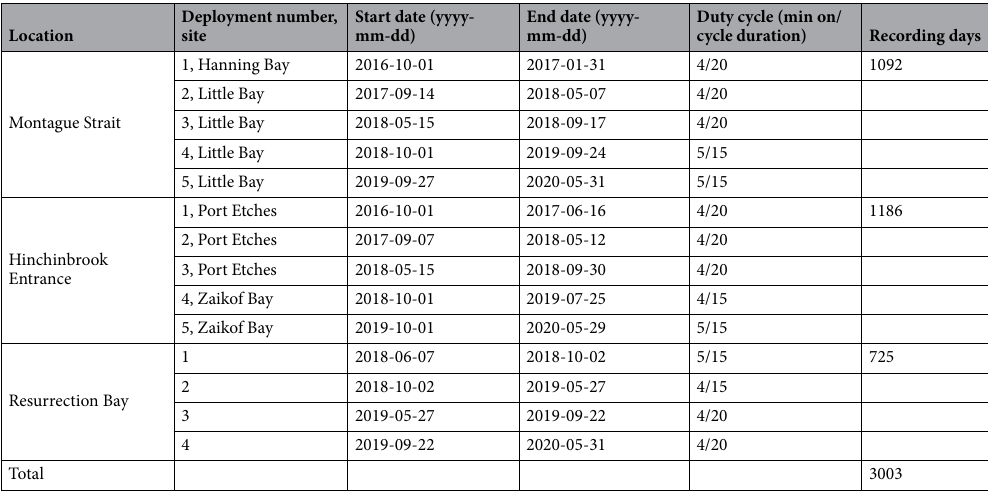
Table 2. Location, deployment number and site, start and end date, duty cycle, and recording days of passive acoustic monitoring data collected in the northern Gulf of Alaska, October 2016 to May